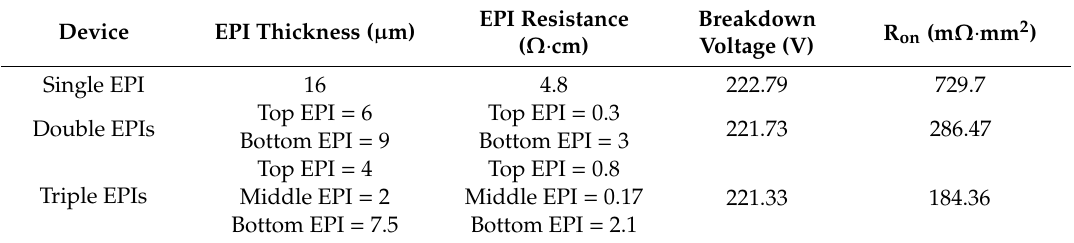
The parameters that were used for the single-EPI, double-EPIs, and triple-EPIs structure simulation.